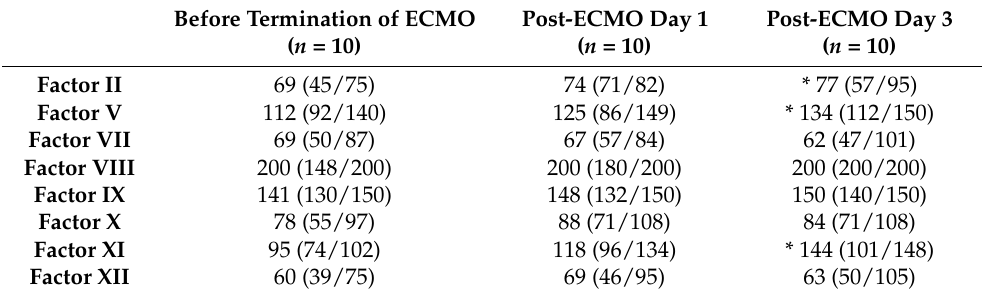
Figure 2. Activity of F XIII before ECMO termination (last value ECMO; n = 14) and 1 (post-ECMO T1; n = 7) as well as 3 days (post-ECMO T3; n = 8) after the termination of vvECMO therapy; * indicates significant increase in F XIII activity compared to last value ECMO; dotted line represents threshold to the normal reference range of F XIII. Table 2. Coagulation factor activity (%) before and after termination of ECMO therapy.